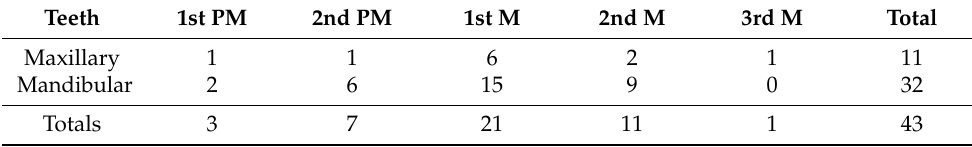
Table 3. Distribution of involved teeth ( N = 43) in the study population.